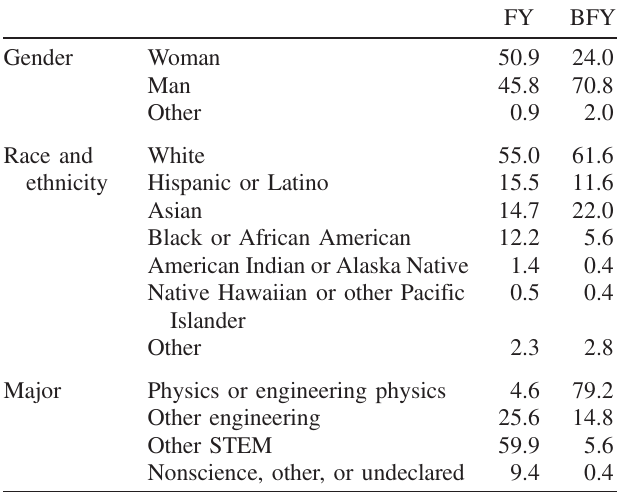
TABLE II. Demographic information in percentages of stu- dents who participated remotely in FY ( N ¼ 4565 ) and BFY ( N ¼ 250 ) courses, with the options as given on the E-CLASS. The race and ethnicity categories correspond to those used by the U.S. Census Bureau [58] and students were allowed to